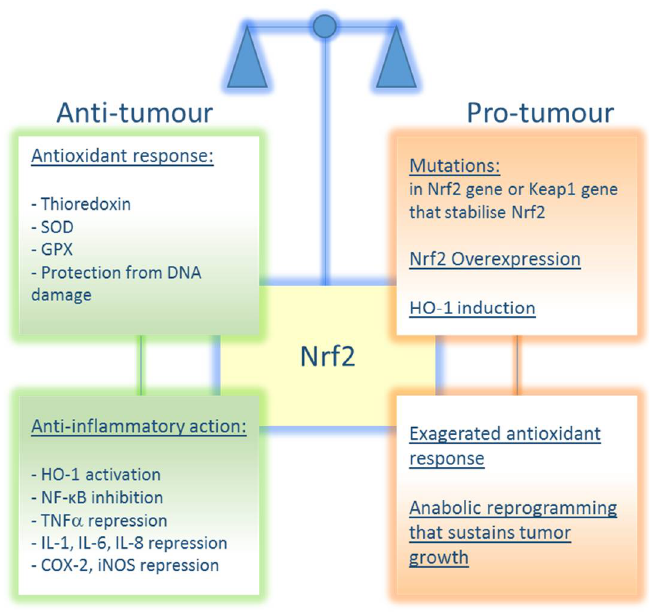
Figure 5. The balance between anti-tumour and pro-tumour roles of Nrf2. Under healthy conditions, Nrf2 promotes concerted antioxidant responses that protect the cells from injury and/or DNA damage. Nrf2 also promotes an anti-inflammatory action that counteracts tumour transformation. On the other hand, when Nrf2 signalling is exacerbated by Nrf2 activating mutations and/or Keap1 affecting ones, an exaggerated antioxidant response may be responsible for tumourigenesis and chemoresistance and unbalanced metabolic reprogramming may sustain cell proliferation and tumour growth.